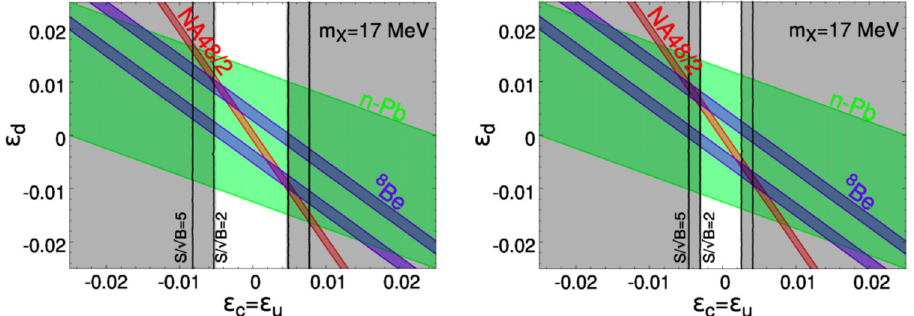
= 10 10 ) and future (right-panel: N Figure 3 . The current (left-panel: N J/ Ψ sensitivities by assuming the reconstruction efficiencies from table 1 and taking the invariant mass cut | M = 2 MeV . Compare with the allowed regions for 8 Be ∗ anomaly, NA48/2 for ee − m X | ≤ σ m π 0 decay [26] and neutron-nucleus scattering